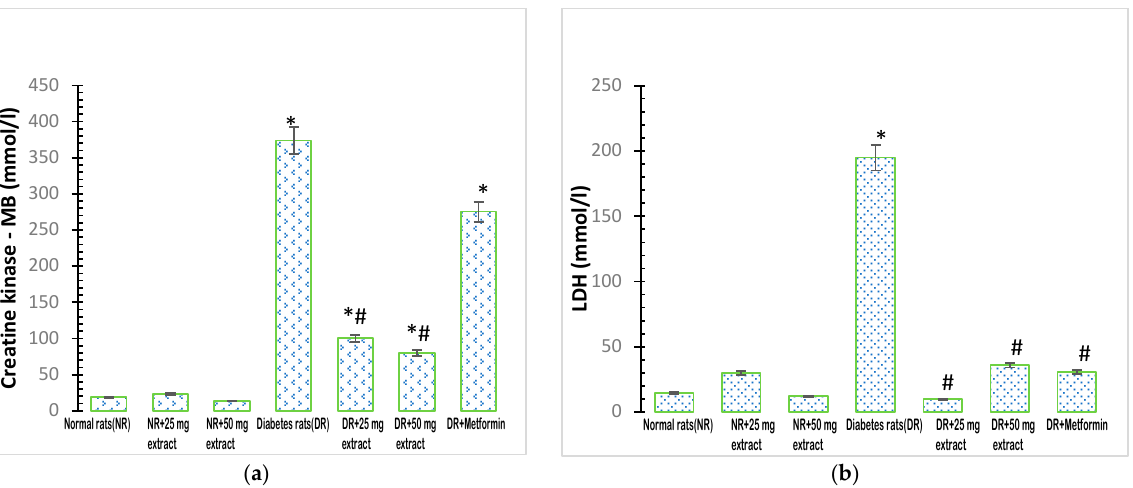
Figure 3. Cardiac biomarkers in rats treated with FFMTSE. ( a ) Activity of creatine kinase-MB (CK-MB) and ( b ) Lactate dehydrogenase (LDH) in rats treated with FFMTSE. All results are expressed as mean ± SD, (*) indicates a significant difference compared to the normal control group at p < 0.05, and (#) indicates a significant difference compared to the diabetic control group at p < 0.05. FFMTSE: flavonoid-rich fraction of Monodora tenuifolia seed